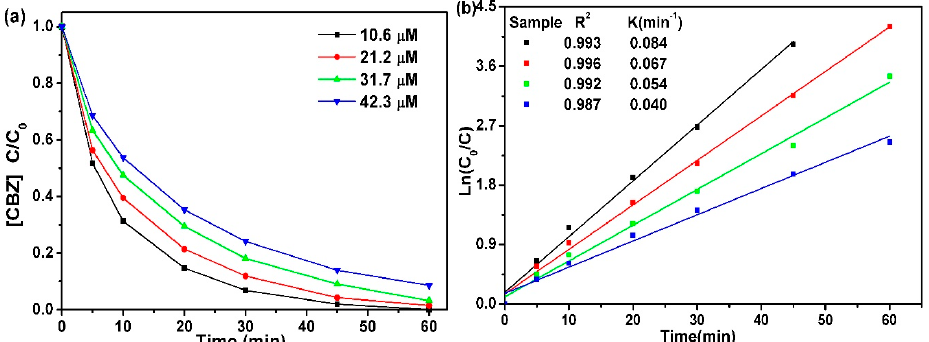
Figure 6. ( a ) Degradation of CBZ by UV-LED/TiO 2 for different initial concentrations of CBZ ( b ) The pseudo-first-order kinetic models of CBZ degradation by UV-LED/TiO 2 for different initial concentrations of CBZ. Operating temperature = 20 °C; wavelength of UV-LED = 365 nm; operating pH = 7.6; and C (mixed-phase TiO 2 ) = 2.0 g/L.